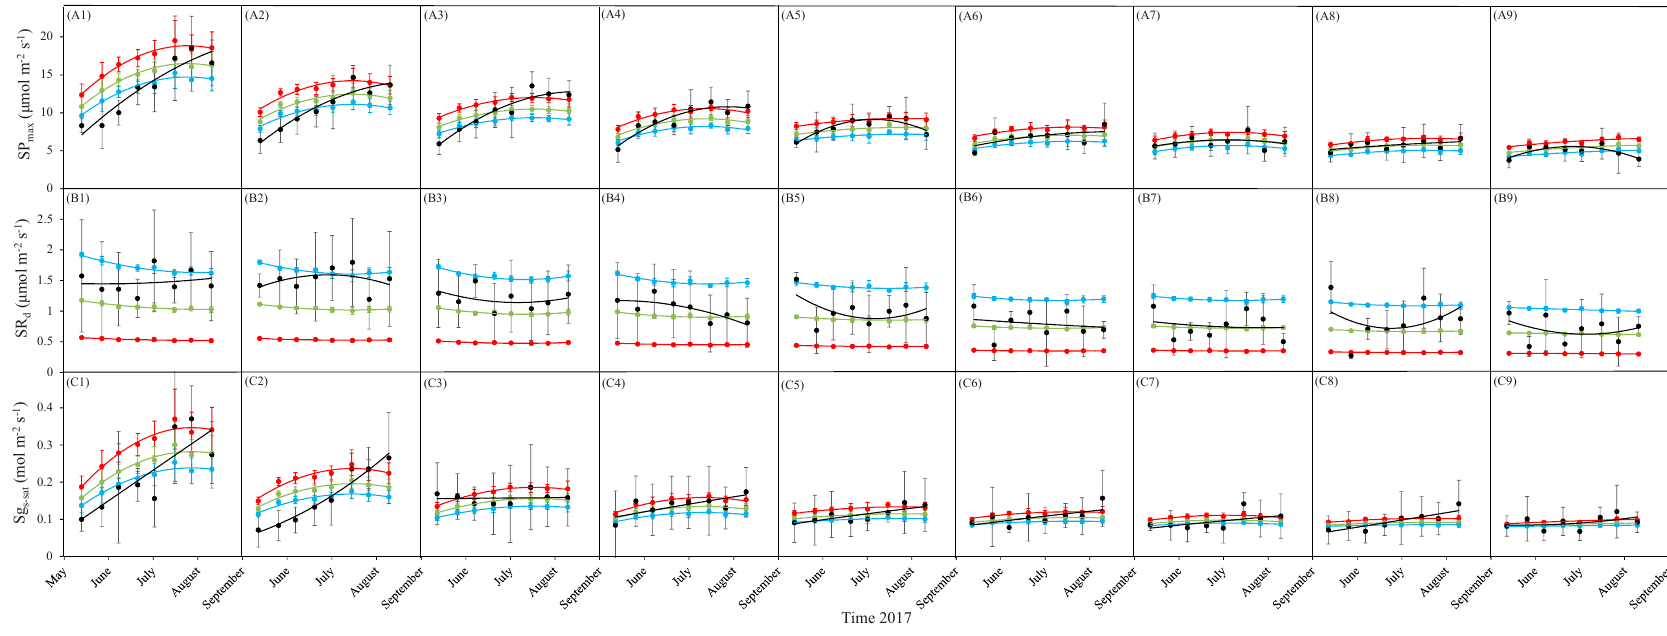
Figure 6. Seasonal evolution of standardized and nonstandardized photosynthetic parameters: ( A ) light-saturated net photosynthetic rate (SP max ), ( B ) dark respiration (SR d ) and ( C ) light-saturated stomatal conductance (Sg s-sat ) during the growing season. (1–9) represent nine vertical positions within the crown from the relative depth into the crown (RDINC) of 0.1 to 0.9, respectively, at 0.1 intervals. Data points represent the mean values (solid bars represent the standard deviation) in each RDINC and measurement period. Solid lines are trend lines.